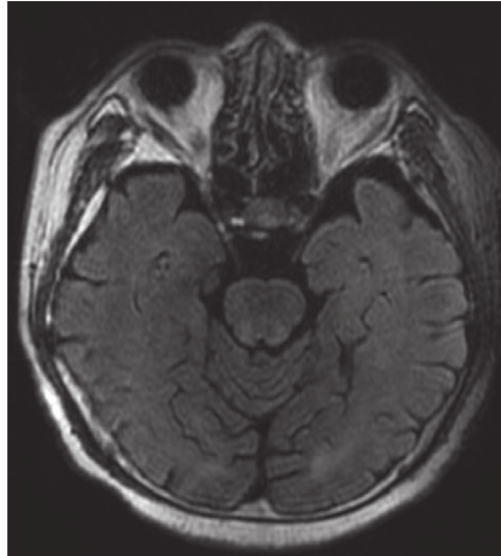
Figure 2: FLAIR image of brain MRI after development of neu- rological symptoms reveals high-intensity area in bilateral temporal lobes (red